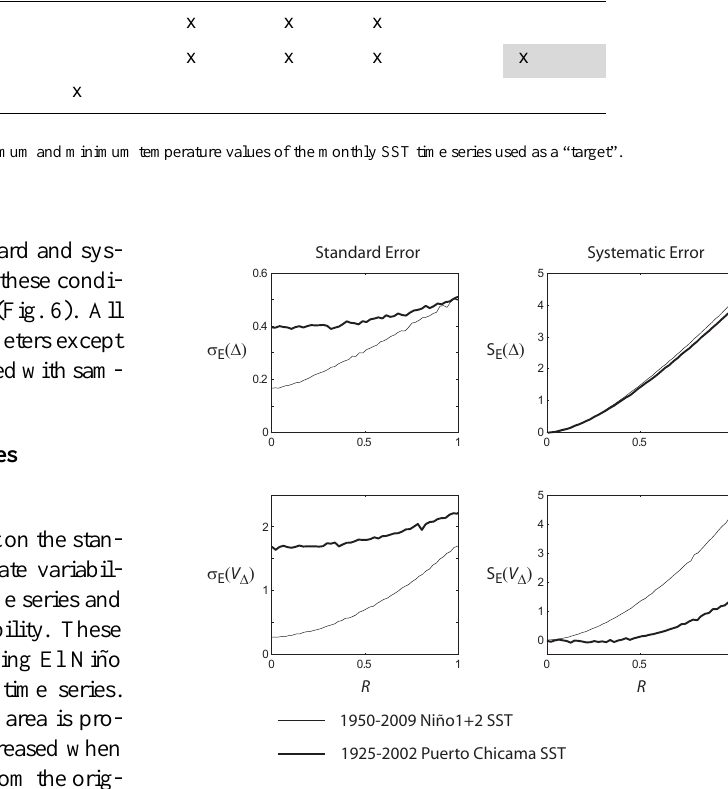
Fig. 4. Results of experiment 3. Standard error and systematic error for 1T and var( 1T ) versus the standard deviation of the monthly stochastic perturbation. The effect was investigated using the 1950– 2009 Ni˜no1+2 (thin line) and the 1925–2002 Puerto Chicama (bold line) time